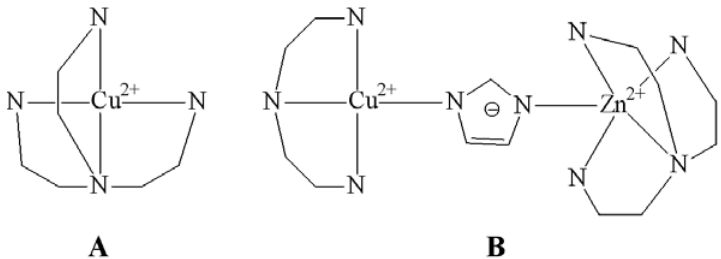
Fig. 1 Structure of the investigated complexes: Cu(II)-tris(2-aminoethyl)amine (A) and Cu(II)-diethylenetriamino– μ -imidazolato–Zn(II)-tris(2-aminoethyl)amine